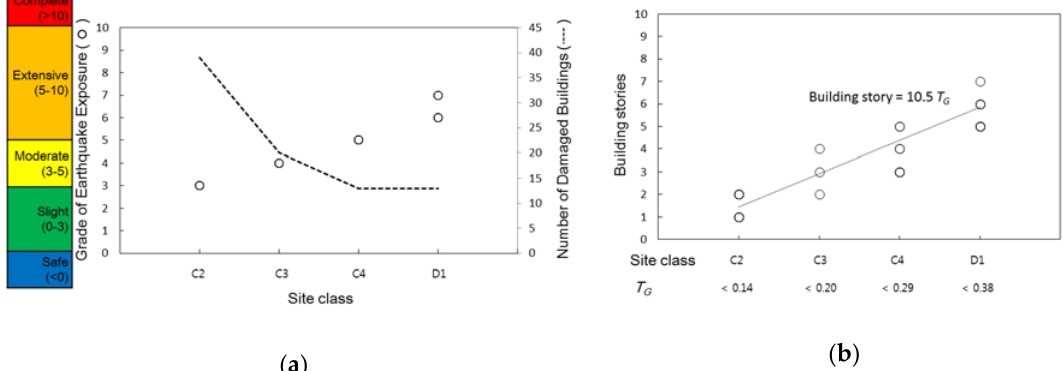
Figure 10. Correlations based on seismic site class: ( a ) grade of earthquake exposure and number of damaged buildings; ( b ) building stories.